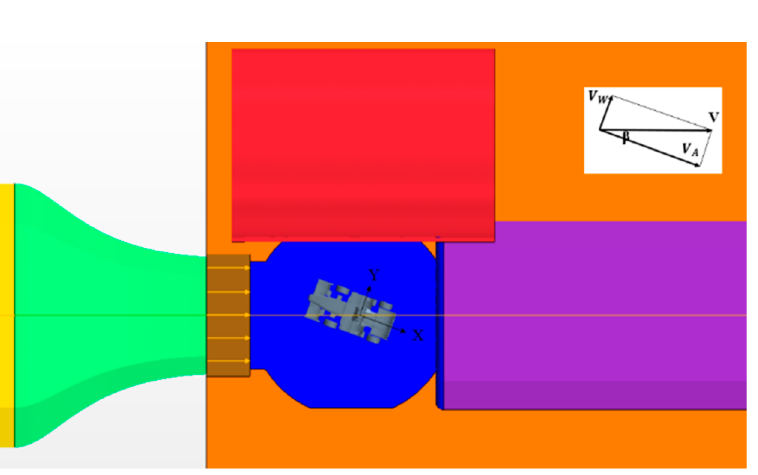
Figure 7. Yaw model method for wind tunnel test.